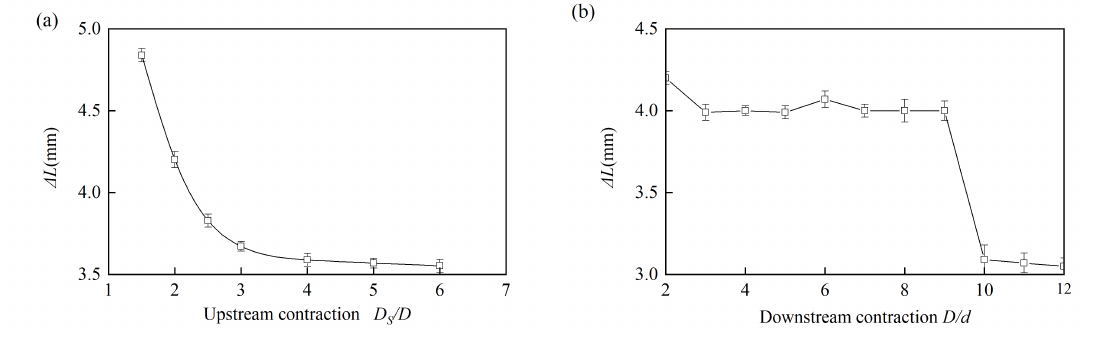
Figure 10. Equivalent extension length ∆ L as a function of upstream and downstream contraction ratio. ( a ) ∆ L as a function of upstream contraction ratio D s / D ; ( b ) ∆ L as a function of downstream contraction ratio D / d